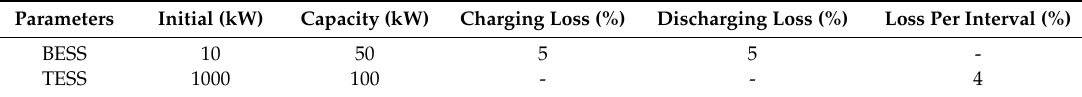
Table 2. Thermal energy storage system (TESS) and battery energy storage system (BESS) parameters.